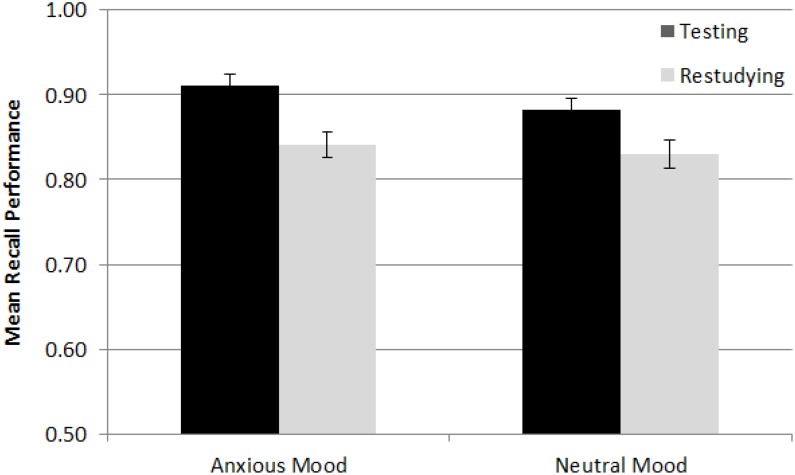
Mean recall performance in the testing and restudying condition of the neutral and anxious mood conditions in Experiment 2. The cell means were averaged across retention intervals (immediate and delayed) and across item types (interesting and boring facts). Error bars indicate the standard errors of means.